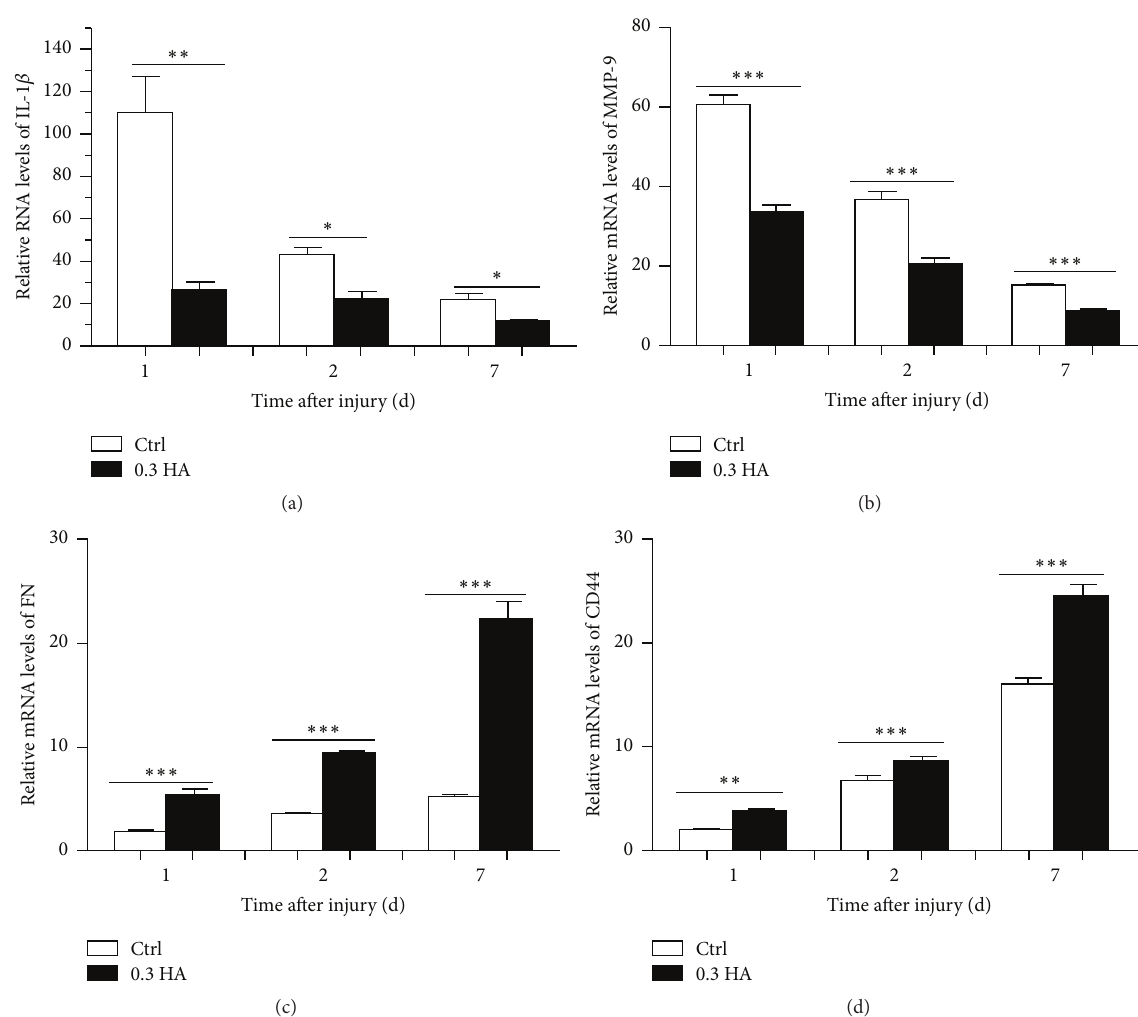
Figure 4: Hyaluronate decreased the expression of inflammatory cytokines and increased the expression of repair factors in vivo . The RNA levels of inflammatory cytokines, including IL-1 𝛽 (a) and MMP-9 (b), and those of repair factors, including FN (c) and CD44 (d), were determined by real-time PCR at 1, 2, and 7d after injury in the control and 0.3 HA groups. The data are the mean ± SEM and represent individual experiments, each including 5 animals/group/time. ∗ 𝑝 < 0.05 ; ∗∗ 𝑝 < 0.01 ; ∗∗∗ 𝑝 < 0.001